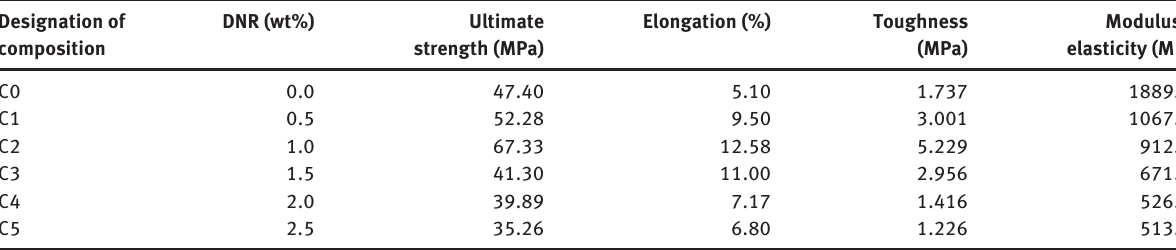
Table 2 Tensile properties of cured epoxy filled with different weight percentages of DNR.